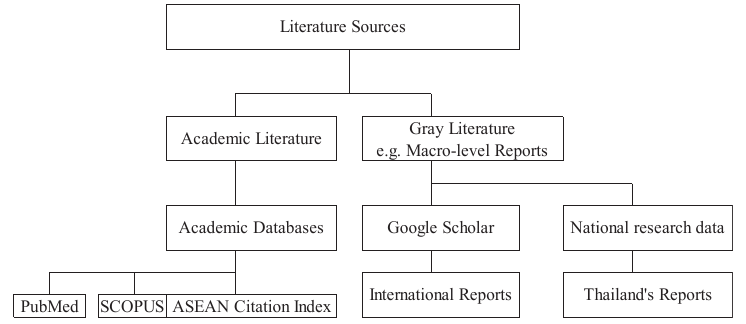
Figure 1. Search strategies